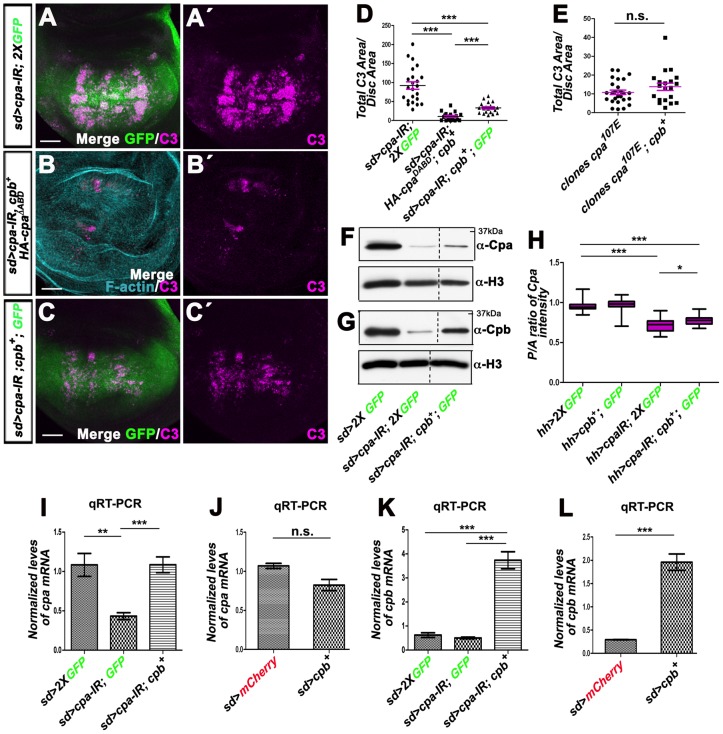
Overexpressing cpb in wing discs knocked-down for cpa, restores cpa mRNA and protein levels and suppresses apoptosis.(A–A′ to C–C′) standard confocal sections of third instar wing imaginal discs with dorsal sides up, expressing (A–A″) UAS-cpa-IRC10 and two copies of UAS-mCD8-GFP (green in A) or (B–B′) UAS-cpa-IRC10, UAS-HA-cpaΔABD and UAS-cpb7 or (C–C′) UAS-cpa-IRC10, UAS-cpb7 and one copy of UAS-mCD8-GFP (green in C) under sd-Gal4 control. Discs are stained with anti-activated-Caspase 3 (magenta), which monitors DRONC activation and (B–B′) Phalloidin (cyan blue in B) to underline wing disc shape. The scale bars represent 30 µm. (D) quantification of total C3 area per disc area for the genotypes sd>cpa-IRC10, 2XGFP (lane 1); sd>cpa-IRC10, HA-cpaΔABD, cpb7 (lane 2) and sd>cpa-IRC10, cpb7, 1XGFP (lane 3). The means for lane 1 is 92.4 (n = 23); for lane 2 is 10.61 (n = 19); for lane 3 is 32.9 (n = 20). Error bars indicate s.e.m. P<0.0001 for comparison of lane 1 and 2 or 3 or lane 2 and 3. (E) quantification of total C3 area per disc area for wing discs containing T155>flp; cpa107E mutant clones (lane 1) or T155>flp; cpa107E mutant clones expressing UAS-cpb7 (lane 2). The means for lane 1 is 10.80 (n = 26); for lane 2 is 13.77 (n = 20). n.s. indicates non-significant P value. (F and G) western blots on protein extracts from wing discs expressing two copies of UAS-mCD8-GFP (lane 1) or UAS-cpa-IRC10 and two copies of UAS-mCD8-GFP (lane 2) or UAS-cpa-IRC10, UAS-cpb7 and one copy of UAS-mCD8-GFP (lane 3) under sd-Gal4 control, blotted with (F) anti-Cpa (upper panel) and anti-H3 (lower panel) or (G) anti-Cpb (upper panel) and anti-H3 (lower panel). Panels derive from the same experiment shown in Figure 5E and F and blots were processed in parallel (see Figure S2 showing the whole experiment). (H) mean intensity of the ratio of Cpa signals between posterior and anterior wing compartments of hh-Gal4 driving two copies of UAS-mCD8-GFP (lane 1) or UAS-cpb7 and one copy of UAS-mCD8-GFP (lane 2) or UAS-cpa-IRC10 and two copies of UAS-mCD8-GFP (lane 3) or UAS-cpa-IRC10 and UAS-cpb7 and one copy of UAS-mCD8-GFP (lane 4). The mean for lane 1 is 0.959 (n = 15), for lane 2 is 0.970 (n = 20), for lane 3 is 0.716 (n = 21), for lane 4 is 0.776 (n = 20). Error bars indicate s.e.m.. P<0.0001 for comparison of lanes 1 and 3 or 4 or P<0.01 for comparison of lanes 3 and 4. (I to L) graph of (I and J) cpa or (K and L) cpb mRNA levels measured by five independent qRT-PCR in wing imaginal discs expressing (I and K) two copies of UAS-mCD8GFP (lane 1) or UAS-cpa-IRC10 and UAS-mCD8GFP (lane 2) or UAS-cpa-IRC10 and UAS-cpb7 (lane 3) or (J and L) UAS-mCherry (lane 1) or UAS-cpb7 (lane 2) under sd-Gal4 control. (I) the means for lane 1 is 1.084; for lane 2 is 0.4328; for lane 3 is 1.086. P<0.0027 for comparison of lane 1 with 2 or P<0.0003 for comparison of lane 2 with 3. (J) the means for lane 1 is 1.07; for lane 2 is 0.824. n.s. indicates non-significant P value. (K) the means for lane 1 is 0.621; for lane 2 is 0.5031; for lane 3 is 3.735. P<0.0001 for comparison of lane 3 with 1 or 2. (L) the means for lane 1 is 0.292; for lane 2 is 1.961. P<0.0001 for comparison of lane 1 and 2. Error bars indicate s.e.m.